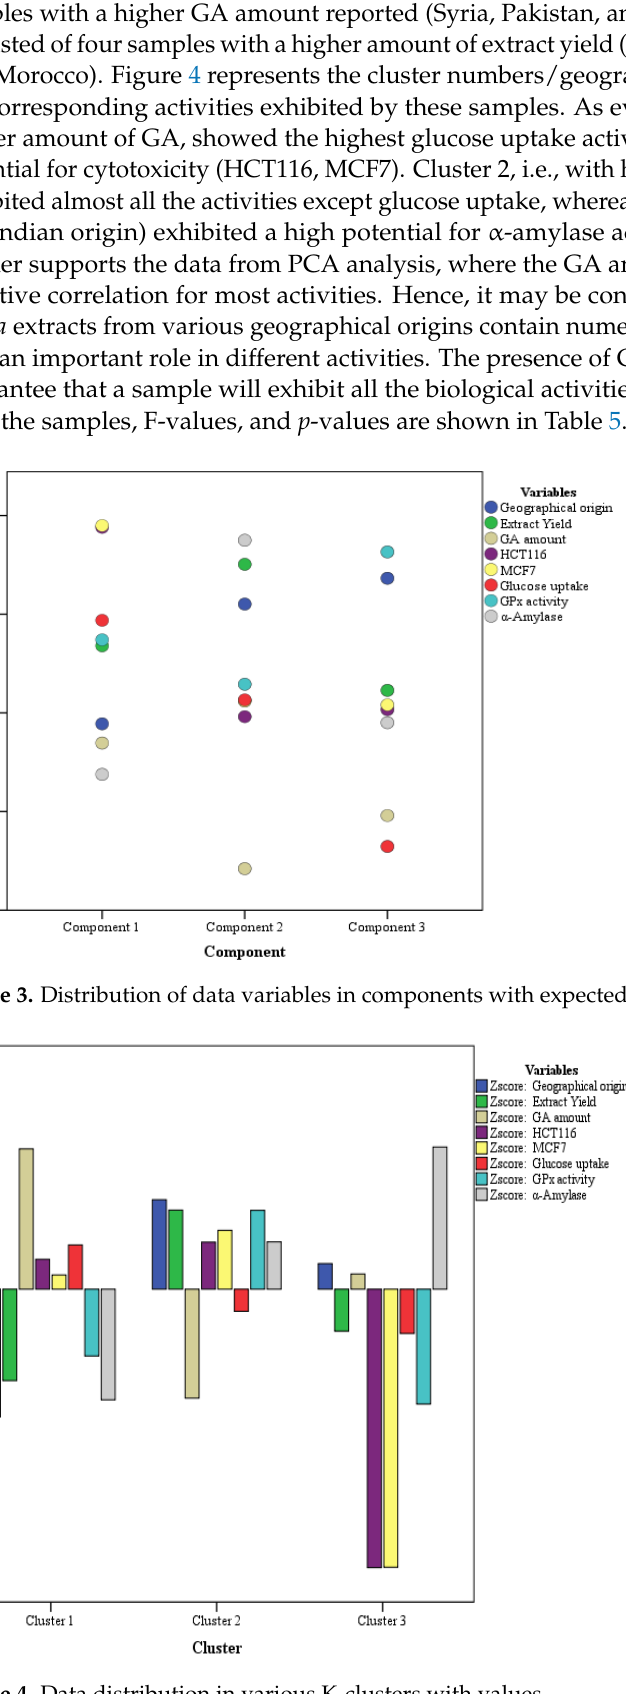
Figure 4. Data distribution in various K-clusters with values.